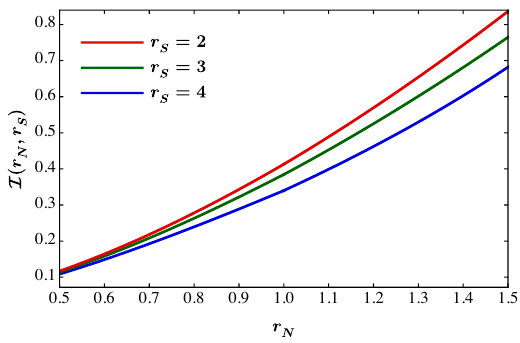
with different choices of r N